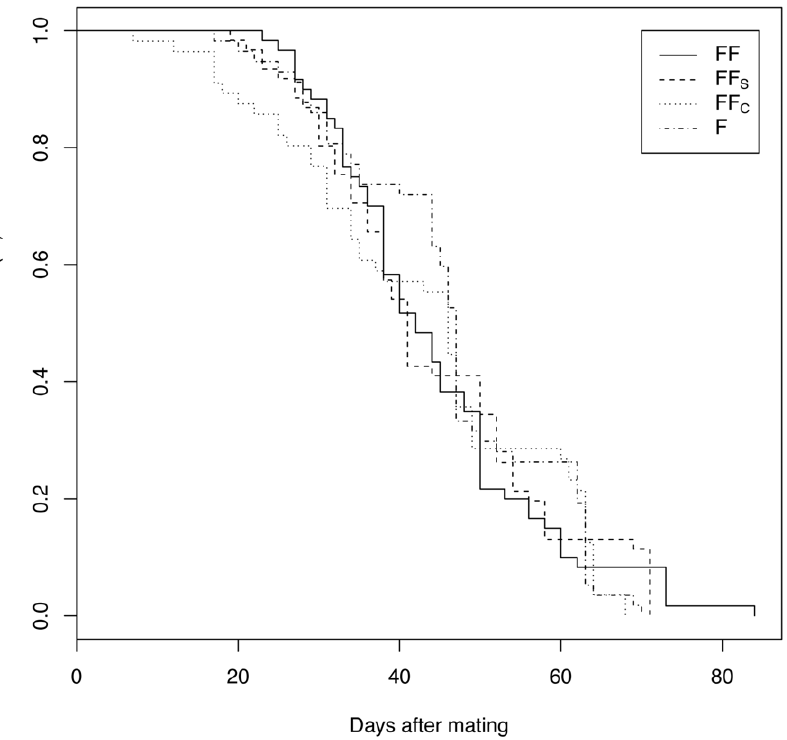
Figure 6. Gryllusfirmus female longevity. Survivorship curves of G. firmus females (1) mated with a normal G. firmus male (FF), (2) mated with a G. firmus male that underwent sham testes removal surgery (FF S ), (3) mated with a G. firmus male surgically castrated (FF C ) or (4) remained unmated (F).